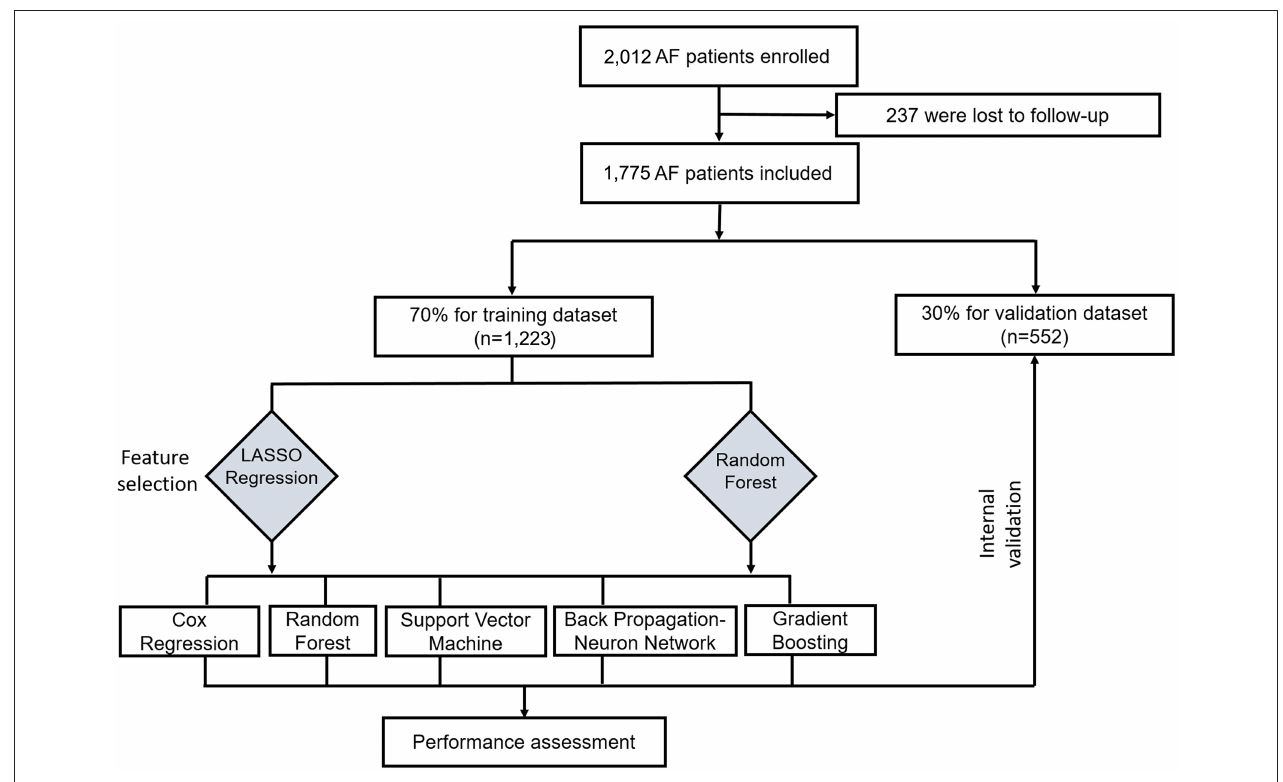
FIGURE 1 | Flow chart for the training and valuation of models. LASSO, least absolute shrinkage and selection operator.